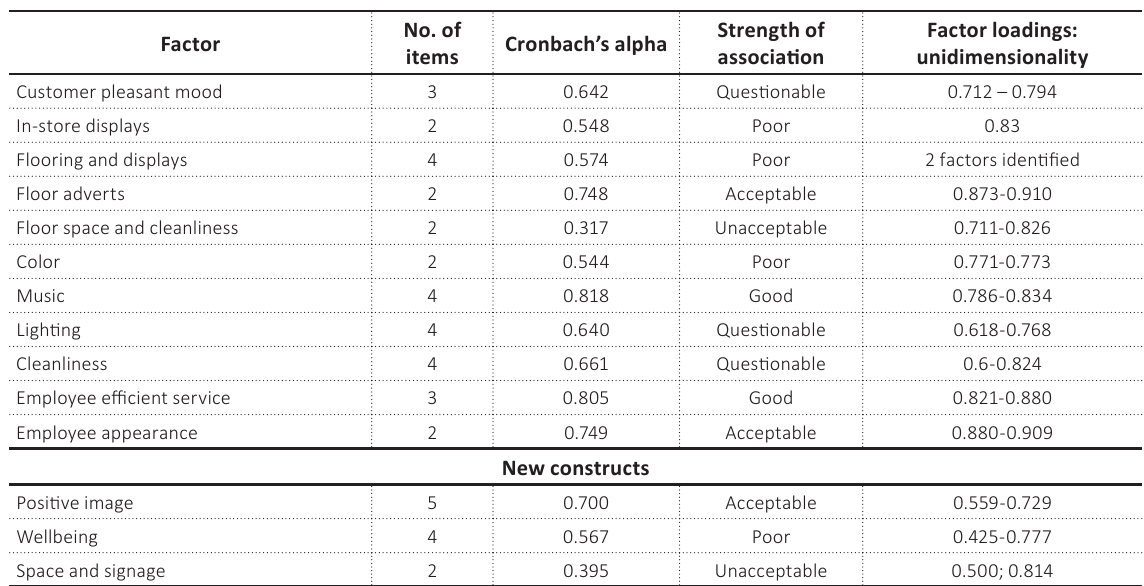
Table 5. Factor analysis and Cronbach’s alpha coefficient